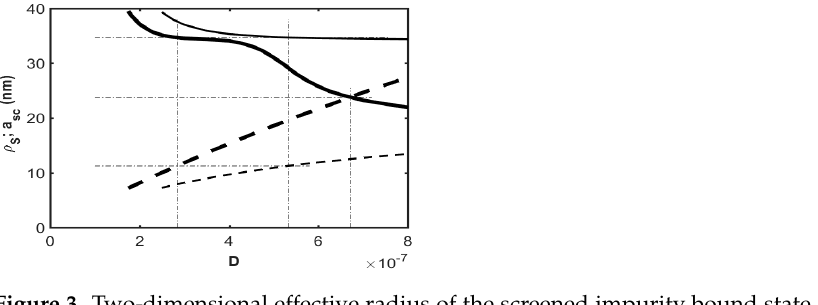
Figure 3. Two-dimensional effective radius of the screened impurity bound state a sc ≈ λ − 1 (solid lines) and 2D screening length ρ s (dashed lines) as a function of the oxide thickness D with the n s / T | a ≈ 6.6 × 10 7 cm − 2 / 0 K parameter (bold lines) and n s / T | b ≈ 6.6 × 10 8 cm − 2 / 0 K parameter (thin lines) for the InSb/SiO 2 /metal (ll- κ type) multi-layer quantum structure.